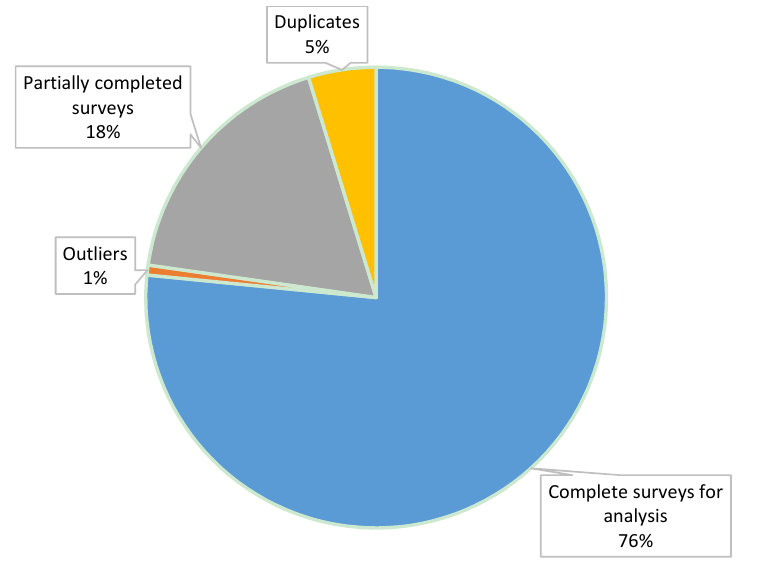
Figure 3. Data management and data cleaning of submitted surveys.